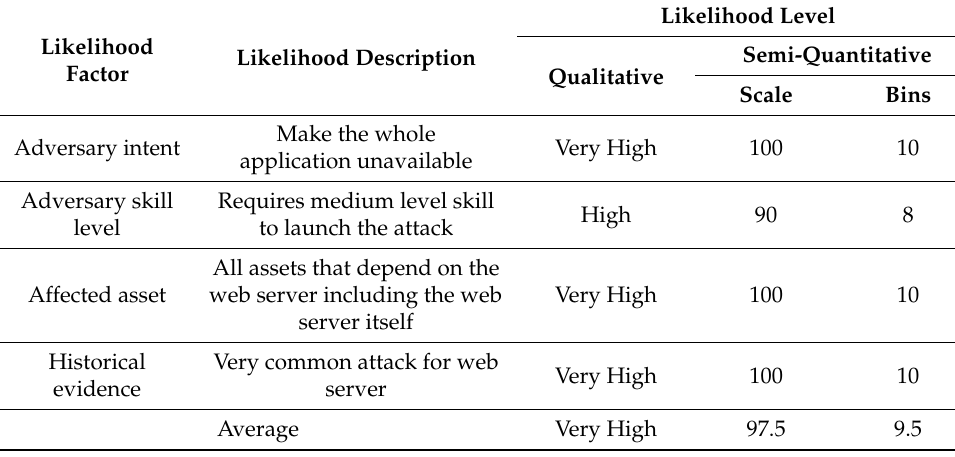
Table 8. Likelihood analysis for DoS attack on a web server.